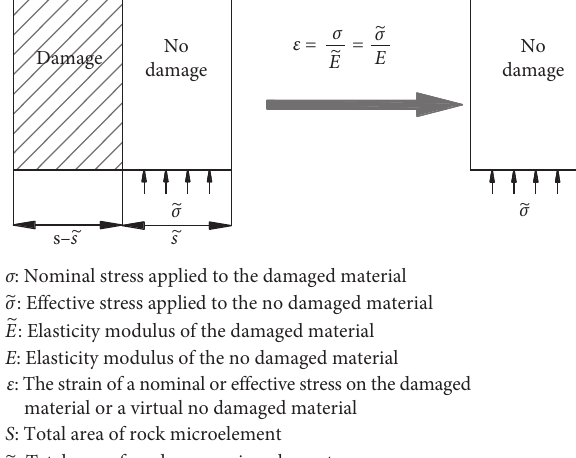
Figure 5: The schematic diagram of strain equivalence principle for rock